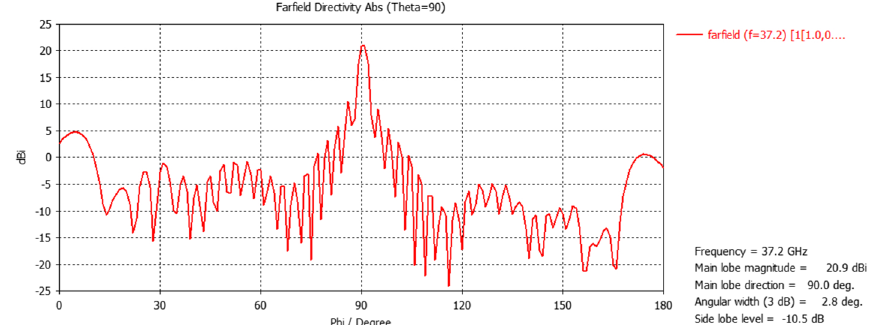
Fig. 7 1-D radiation pattern at frequency F = 37.2 GHz for antenna with identical irregularities